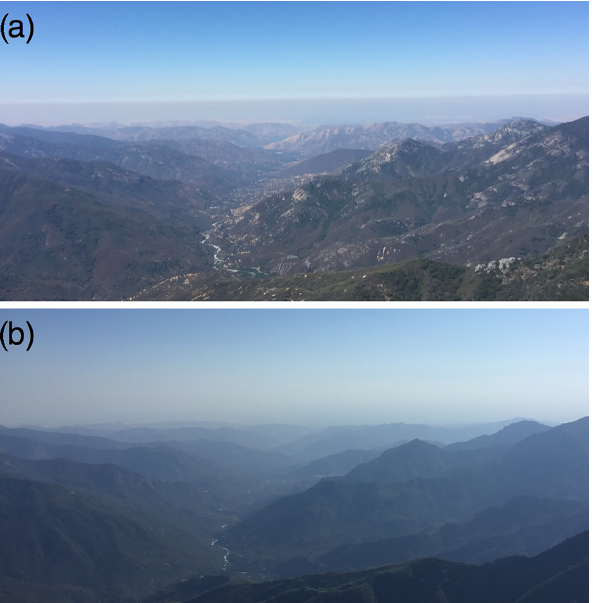
Figure 3. Looking toward the SJV from Moro Rock in SNP (36.5469 ◦ N, 118.7656 ◦ W; 2050ma . s . l . ) at 11:00LT (a) and 17:30LT (b) . Photographs were taken by the authors on 29 June